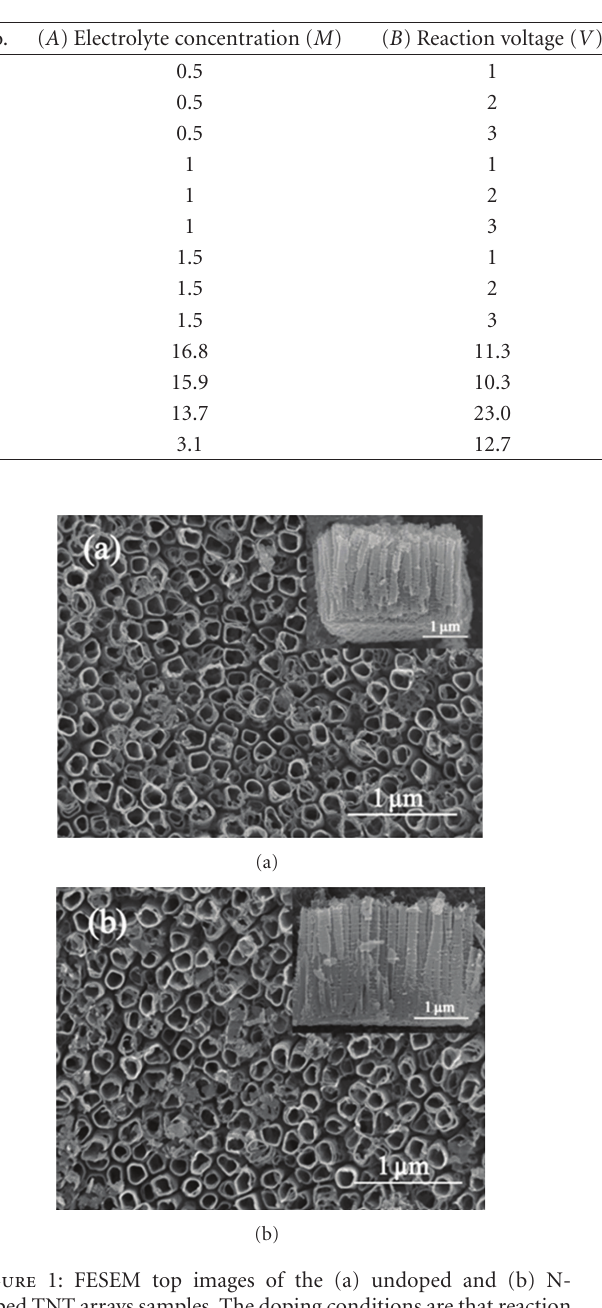
Table 2: Results of the orthogonal experiment.